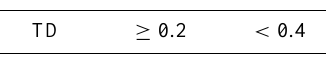
Ulysses III interval; dashed-dotted are the limits of the types; see